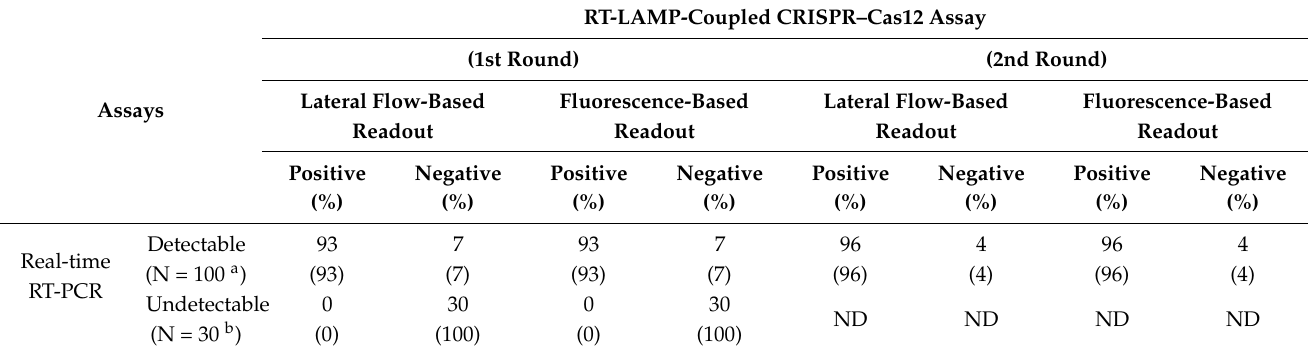
Figure 3. Optimization of CRISPR–Cas12 assay for HCV RNA detection using lateral flow-based readout. ( a ) Optimization using an HCV positive sample/control with various concentrations of lateral flow reporter, i.e., 1000, 500, 250, 125, and 62.5 nM at 37 °C for 10 min or ( b ) 30 min. ( c ) Optimization using NTC with various concentrations of lateral flow reporter at 10 min or ( d ) 30 min. ( e ) Results at different readout time of an HCV positive sample/control and NTC. T, Test line; C, Control line; PC, positive control; NTC, no template control.